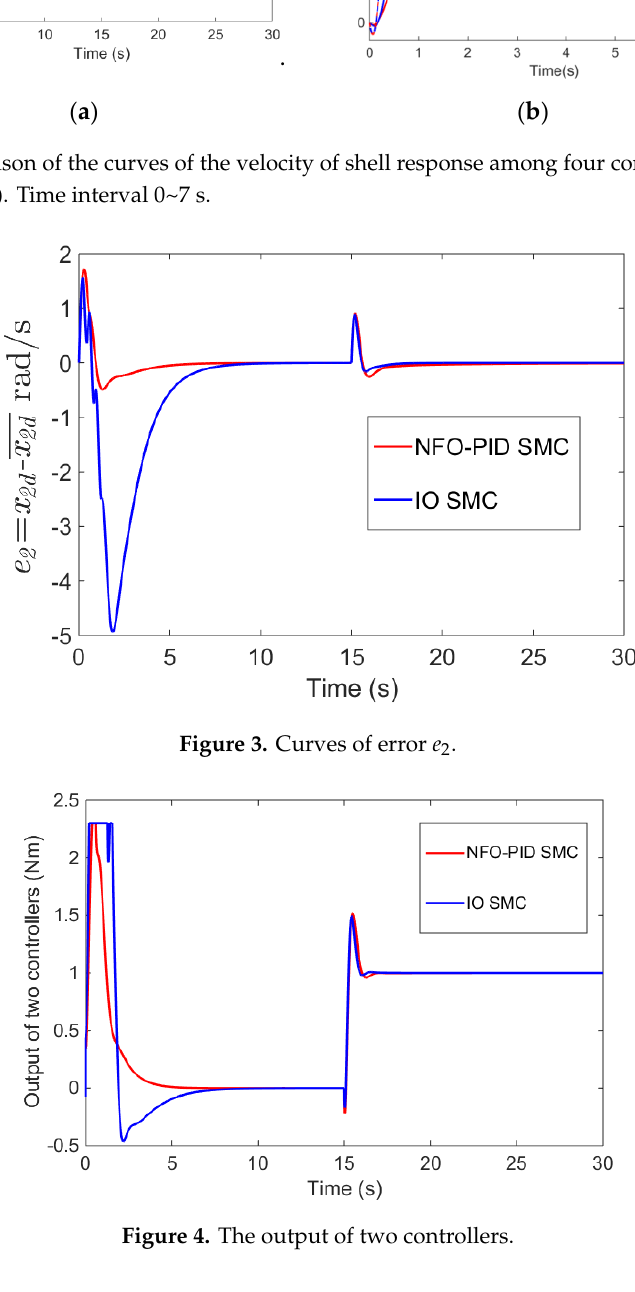
Figure 4. The output of two controllers.